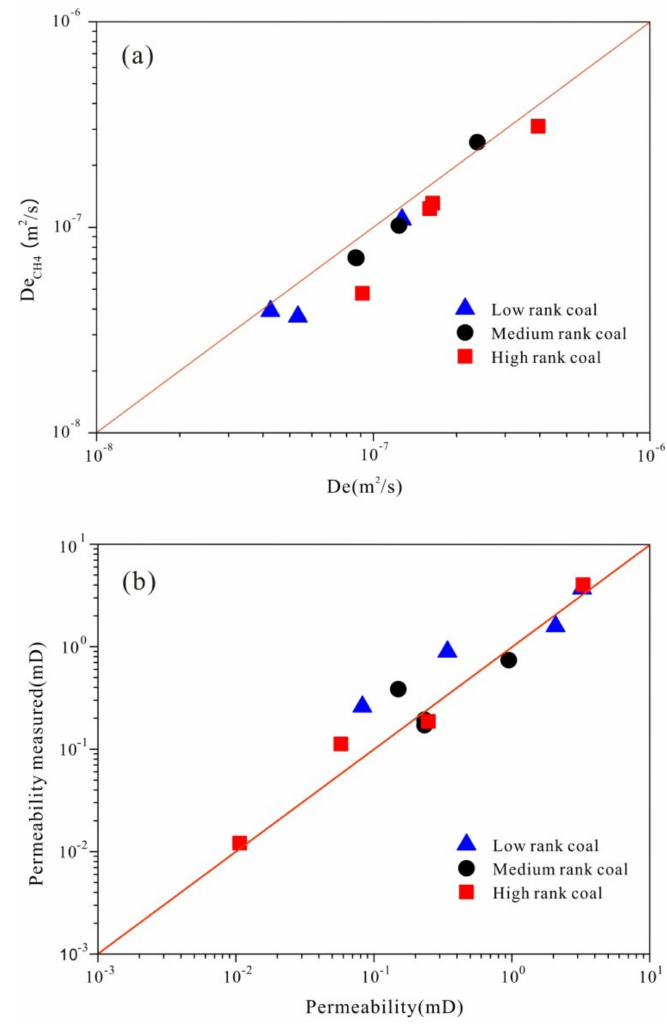
Figure 4. Comparison of effective diffusion coefficients, permeability obtained by theoretical calculation with experimental results. ( a ) demonstrates that the comparison of effective diffusion coefficient from the theoretical calculation and experimental approach by CH 4 diffusion, which shows that the effective diffusion coefficient calculated in this work is slightly higher than the experimental result by CH 4 diffusion; ( b ) shows that the theoretical calculation and experimental permeability by CH 4 are distributed equally near the straight line with the slope equals to